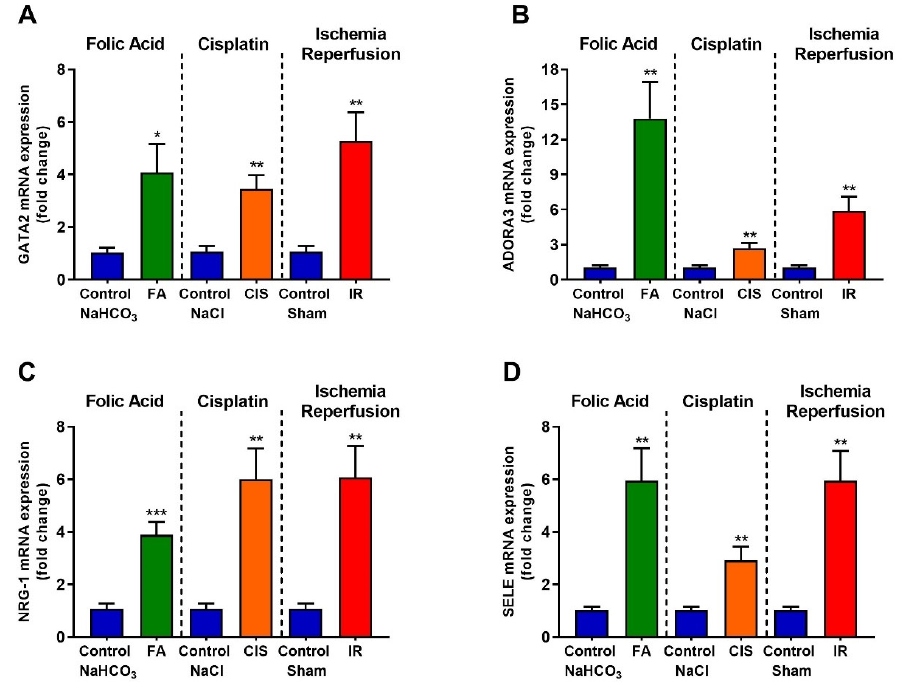
Figure 7. CKD leads to increased activation of GATA-2. Renal mRNA expression of GATA-2 ( A ) and GATA-2 target genes ( B – D ) after folic acid (FA) treatment, cisplatin (CIS) treatment, and ischemia reperfusion (IR) surgery. Data presented as mean ± SEM; n = 6. Two-tailed Student’s t-test. * p < 0.05; ** p < 0.01; *** p < 0.001.